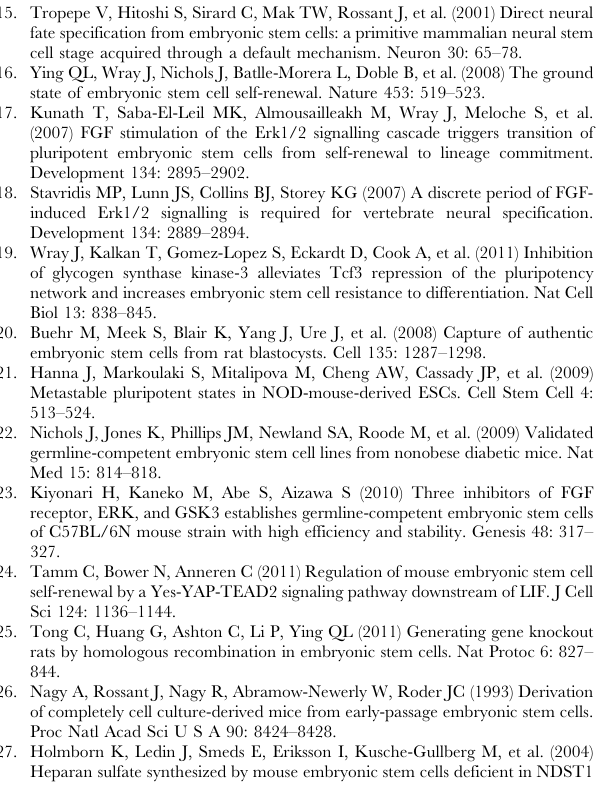
Figure S1 Mouse ES cell adherence in 2i media. Phase- contrast micrographs of colony/spheroid morphology of E14 mES cells seeded onto gelatin, fibronectin, or collagen (A) and cultured in 2i, and (B) on gelatin in 2i media supplemented with either 2% FBS or 2% KOSR. Figure S2 Analysis of ES cells as assessed by quantita- tive PCR. Quantitative PCR analysis at passage 15 for genes associated with undifferentiated mES cells, i.e. Oct4 and Fgf4, as well as early indicator genes for the three germ layers (endoderm: Dab2 and Gata6; ectoderm: Fgf5 and Pax6; mesoderm: Brc and Actc1). Graphs represent pooled results for mES cell lines grown on feeders and gelatin in SCM, mES Prime Kit or 2i media, or in suspension in 2i or ESN2 media. 18S expression is used for normalization, and results are comparative (mES cultures on feeders in SCM set as control) Ct value means 6 sd (n= 3). Figure S3 Beta-galactosidase activity in mouse ES cells cultured in SCM or 2i media. Corresponding beta-galacto- sidase activity for luciferase activity measurements presented in Fig 5B 24 hrs post-transfection in E14 cells cultured without LIF in serum-free SCM with or without PD0325901 (1 m M) and